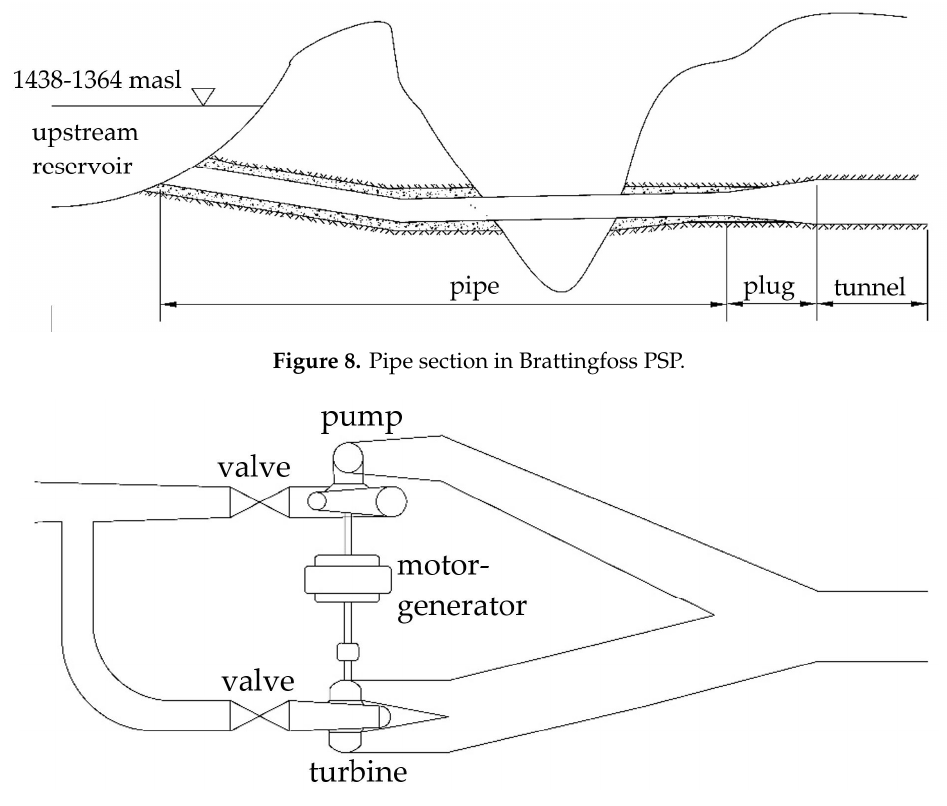
Figure 9. Electromechanical layout plan view in Brattingfoss PSP, planar